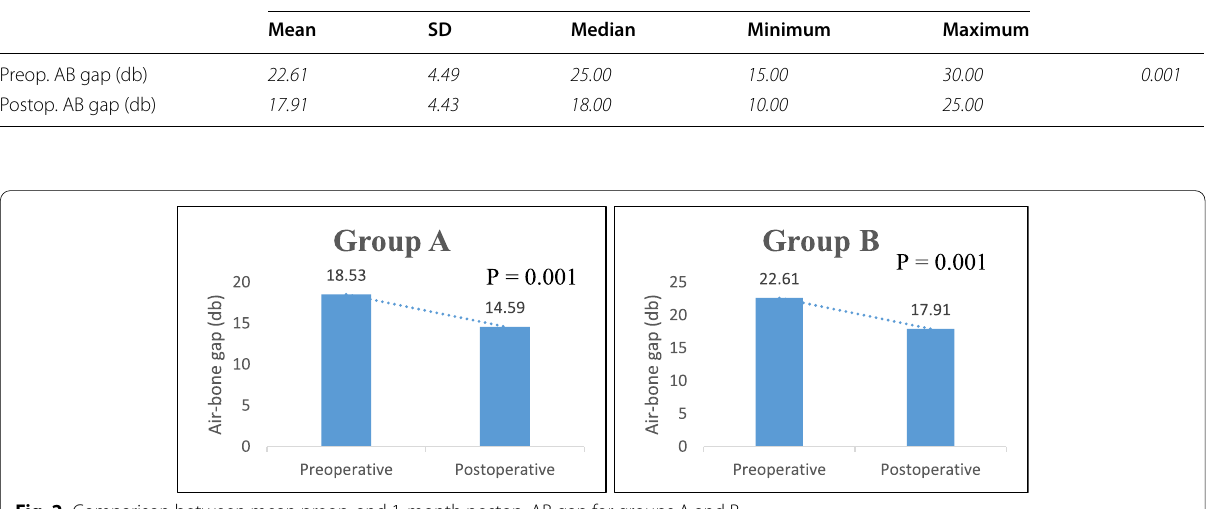
Fig. 2 Comparison between mean preop. and 1-month postop. AB gap for groups A and